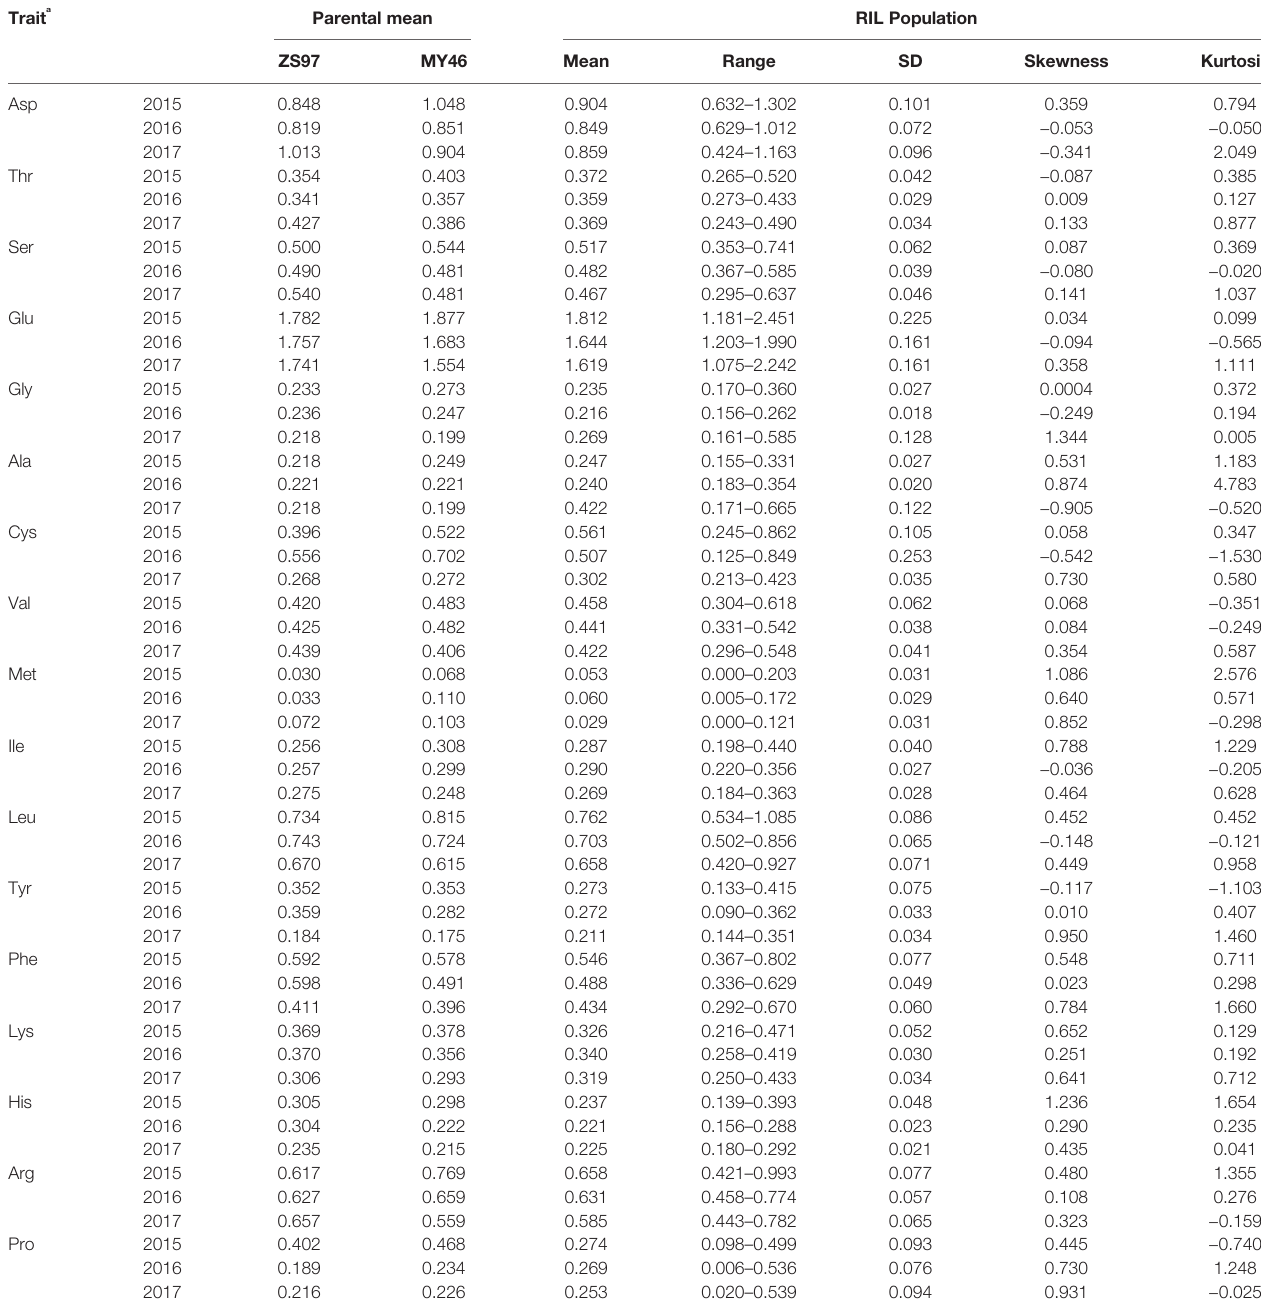
TABLE 1 | Phenotype performance of 17 components of amino acid content in the ZS97/MY46 recombinant inbred line (RIL) population. Trait